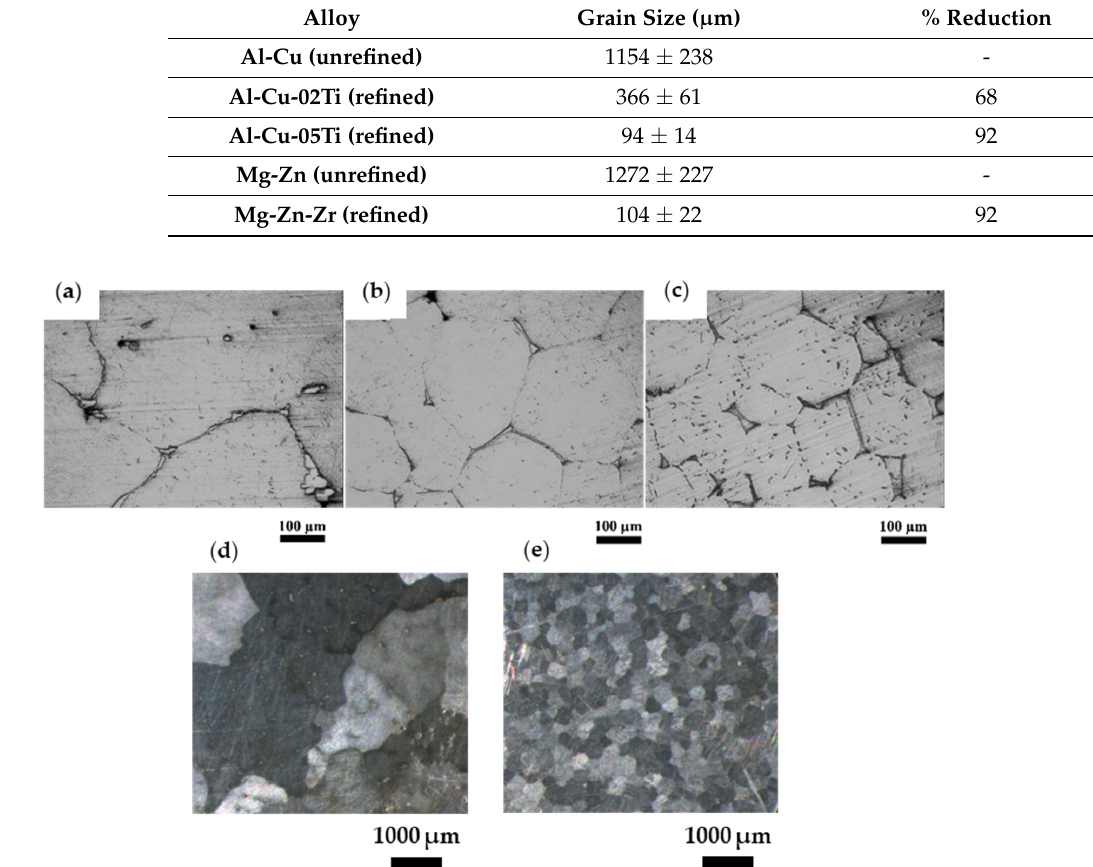
Figure 2. Grain structures of ( a ) Al-Cu, ( b ) Al-Cu-02Ti, ( c ) Al-Cu-05Ti, ( d ) Mg-Zn and ( e ) Mg-Zn-Zr after in-situ neutron diffraction experiments.